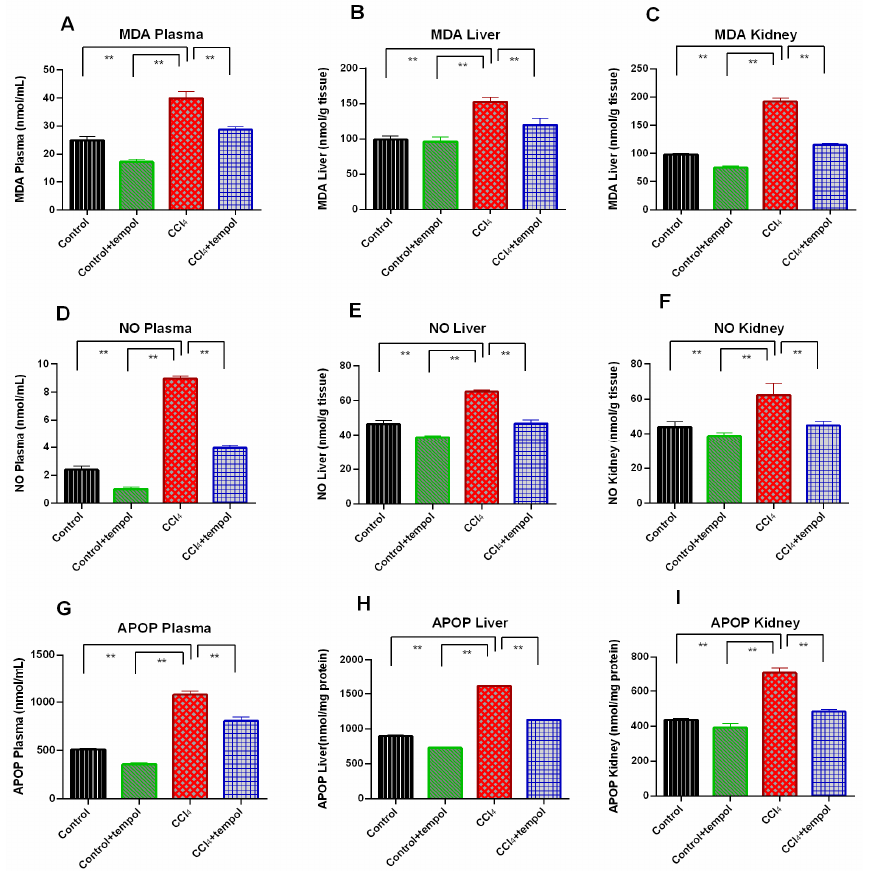
Figure 3. Effect of tempol on oxidative stress parameters in CCl 4 -administered rats. In this figure ( A ). MDA plasma ( B ). NO Plasma ( C ). APOP Plasma ( D ). MDA Liver ( E ). NO Liver ( F ). APOP Liver ( G ). MDA Kidney ( H ). NO Kidney ( I ). APOP Kidney. Every value was represented as mean ± SEM. N =